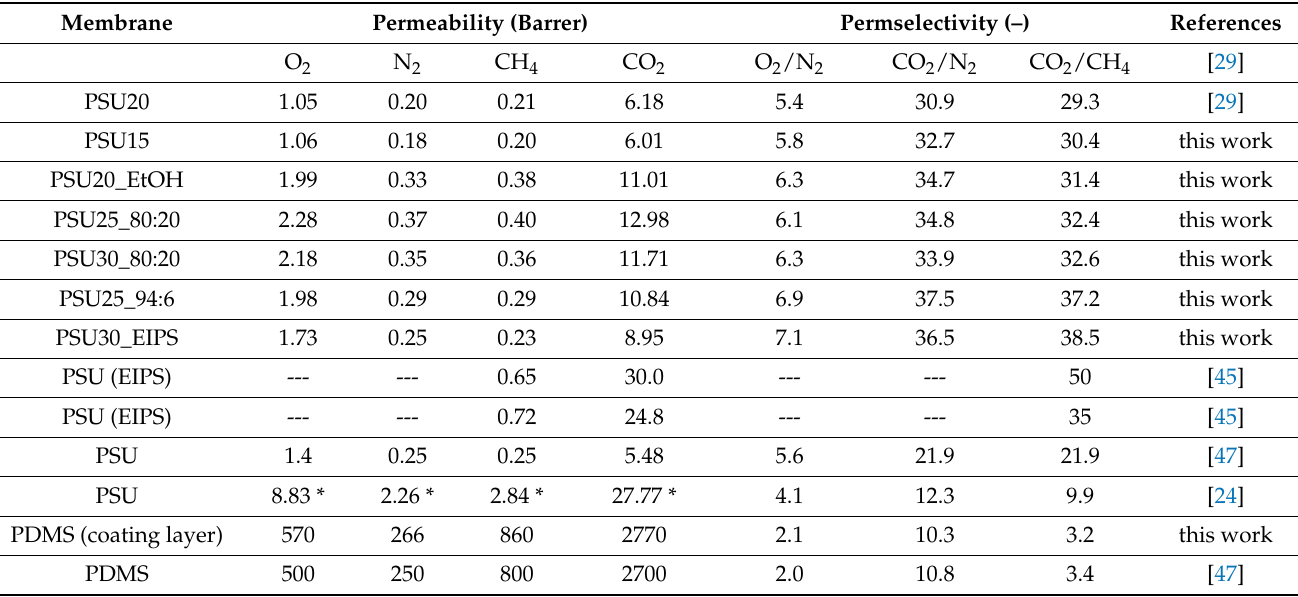
Table 3. Permeabilities and permselectivities of PSU and PDMS flat sheet membranes. * data given